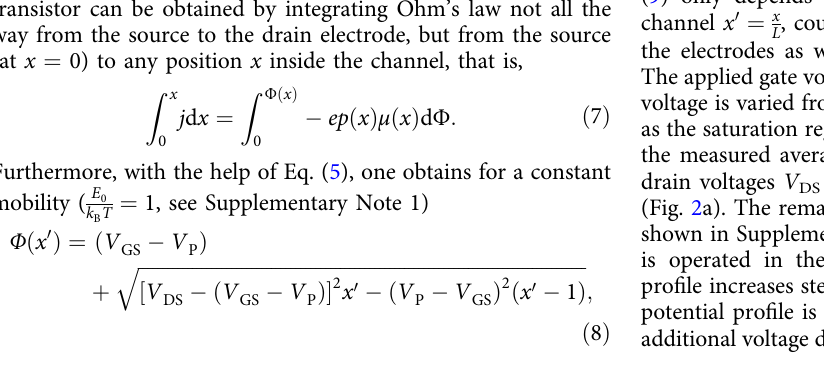
evaporation and structured by photolithography. PEDOT:PSS is spin coated onto the electrodes and etched by oxygen plasma using a shadow mask to remove the semiconductor outside the gate and channel area. The electrolyte is prepared by mixing the room temperature ionic liquid (1-ethyl-3-methylimidazolium ethyl sulfate (C2MIM EtSo4)) and 100 mM sodium chloride in a 4:1 ratio. The electrolyte is placed on top of the gate and channel area. All devices are characterized inside a glovebox (Nitrogen). Process details are given in the “ Methods ” section. Four identical samples are processed for every data point. The results shown in the following are obtained for devices with a PEDOT:PSS layer thickness of 180 nm, unless otherwise noted.